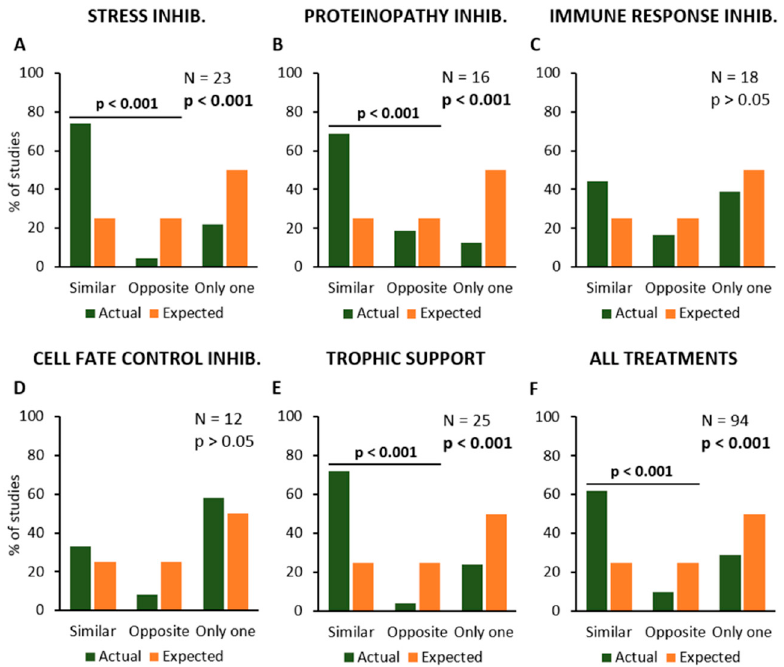
Figure 4. Frequency distribution of the primary studies showing similar or opposite modification of symptom onset and survival time, or the modification of only one parameter, in response to the different types of treatment or experimental manipulation. Percent number of studies where the effect was observed (in green), are compared to the expected values (null hypothesis, in orange). The modifications of onset (anticipation or delay) and survival time (reduction or extension) are shown in relation to the inhibition of Stress ( A ), Proteinopathy ( B ), Immune Response ( C ) and Cell Fate Control mechanisms ( D ), and stimulation of Trophic Support ( E ). The average effects of all treatments together are shown in ( F ). Each graph shows the total number of studies where the effects of a given kind of treatment or manipulation has been evaluated and the p -value calculated by using the Chi-square statistical test. The horizontal bars and the relative p -values are relative to a Chi-square test comparing similar and opposite effects, with the exclusion of studies reporting effects on only one parameter (onset or